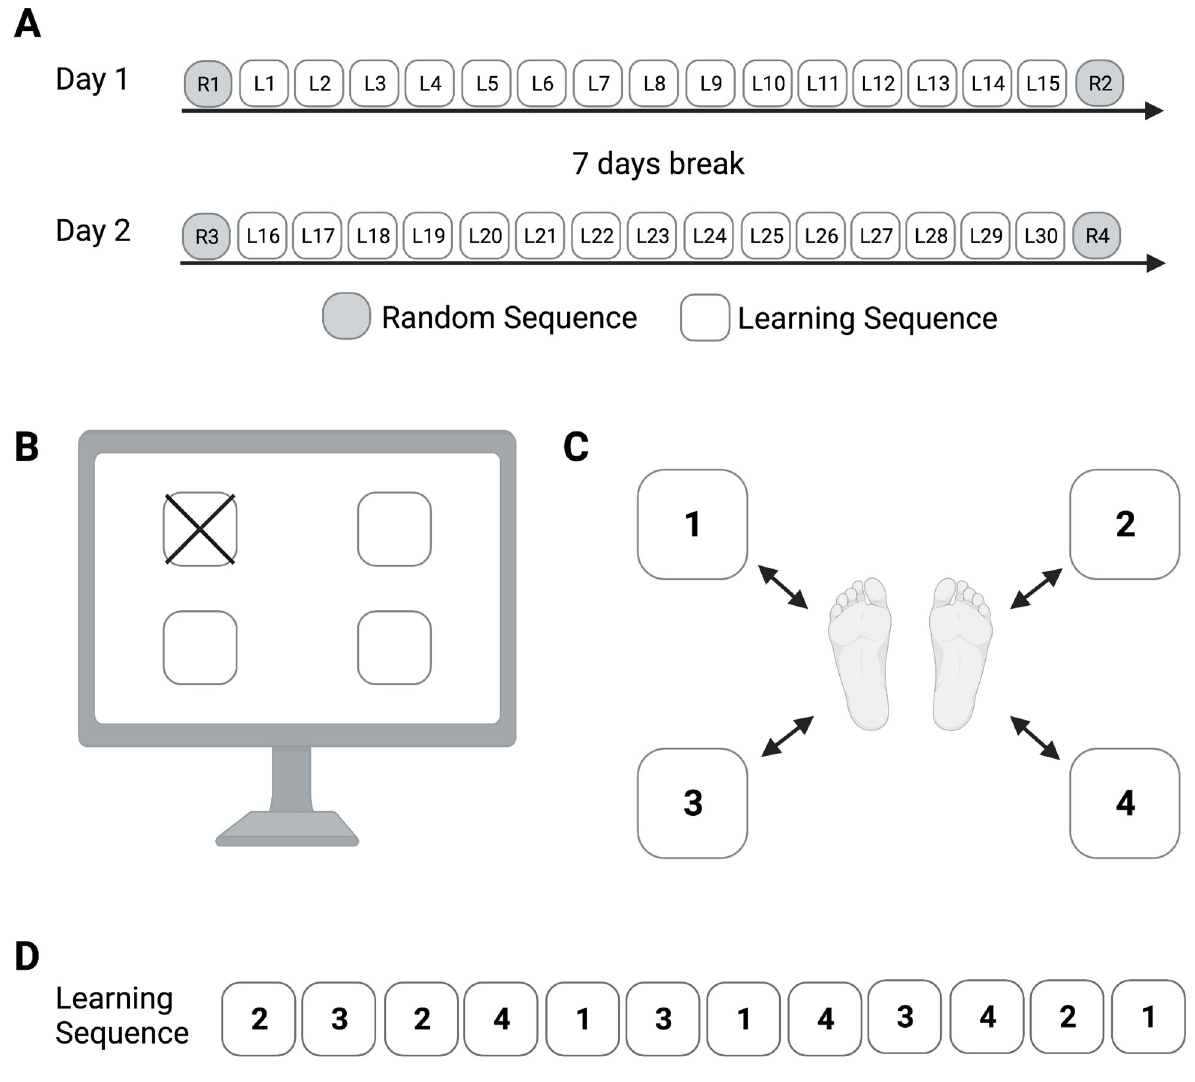
Fig 1. Sensorimotor skill learning using a complex whole-body serial reaction time task (CWB-SRTT). (A) A general overview of the study. Football players (FG) and non-athlete control participants (CG) completed CWB-SRTT on two days separated by a week. On each day participants performed 15 learning sequences (L1-L15; L16-L30), as well as one random sequence before and after the learning sequences (R1, R2, R3, R4). (B) A target cue displayed on any of four squares on a monitor situated 2 meters in front of the participant indicated the plate to be stepped on. (C) The participants’ starting positions during the CWB-SRTT. The target plates were spaced by 0.5 m in both the lateral and longitudinal directions. All plates on the left side had to be operated with the left foot, and all plates on the right side had to be operated with the right foot. The number of plates in each position is related to a number in the learning sequence (1: front left; 2: front right; 3: back left; 4: back right). (D) The fixed learning sequence during all learning blocks appeared in the following order: 2-3-2-4-1-3-1-4-3-4-2-1. This figure was created with Biorender.com.